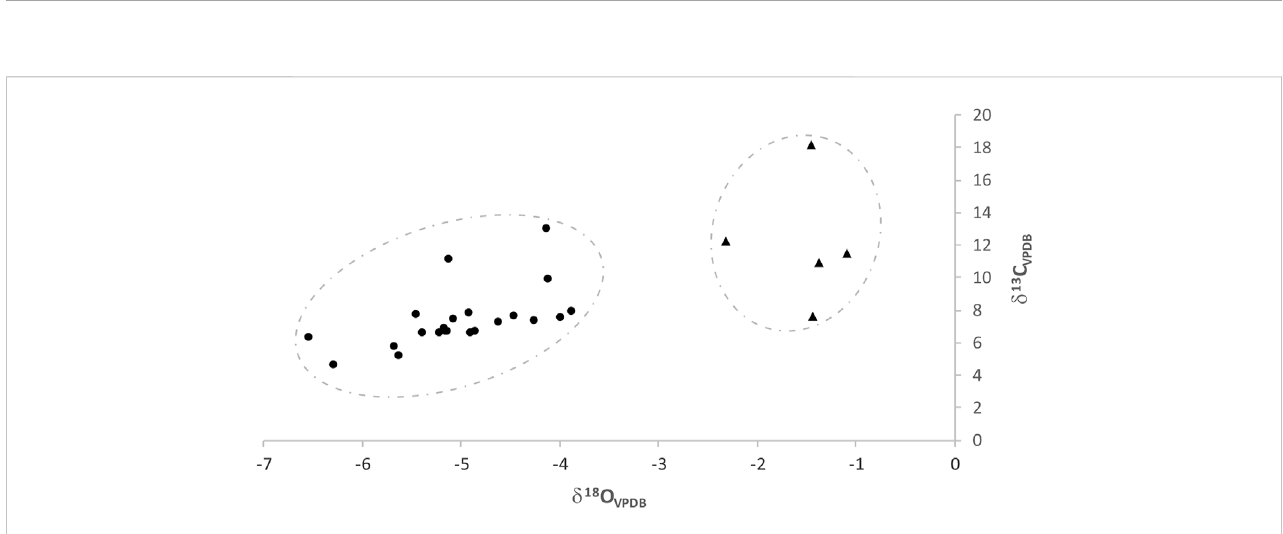
FIGURE 13 δ 13 C ( ‰ , VPDB) and δ 18 O ( ‰ , VPDB) isotope values diagram obtained for the carbonates samples in Carraclaca site. We can observe a difference in the samples distribution, with those represented by triangles having an enrichment in both isotopes, especially for the oxygen, with respect to those represented by